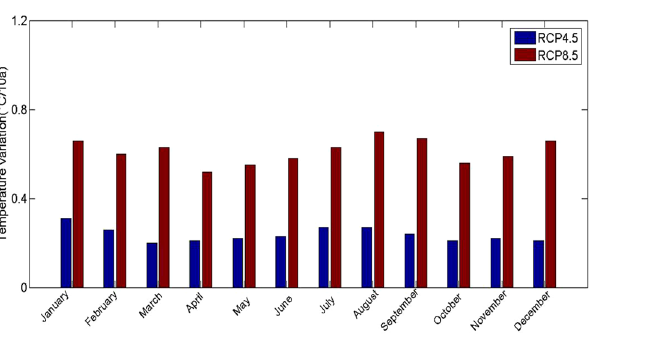
Figure 9. The simulation englacial stresses. ( a ) σ xz and ( b ) σ xy 54 .